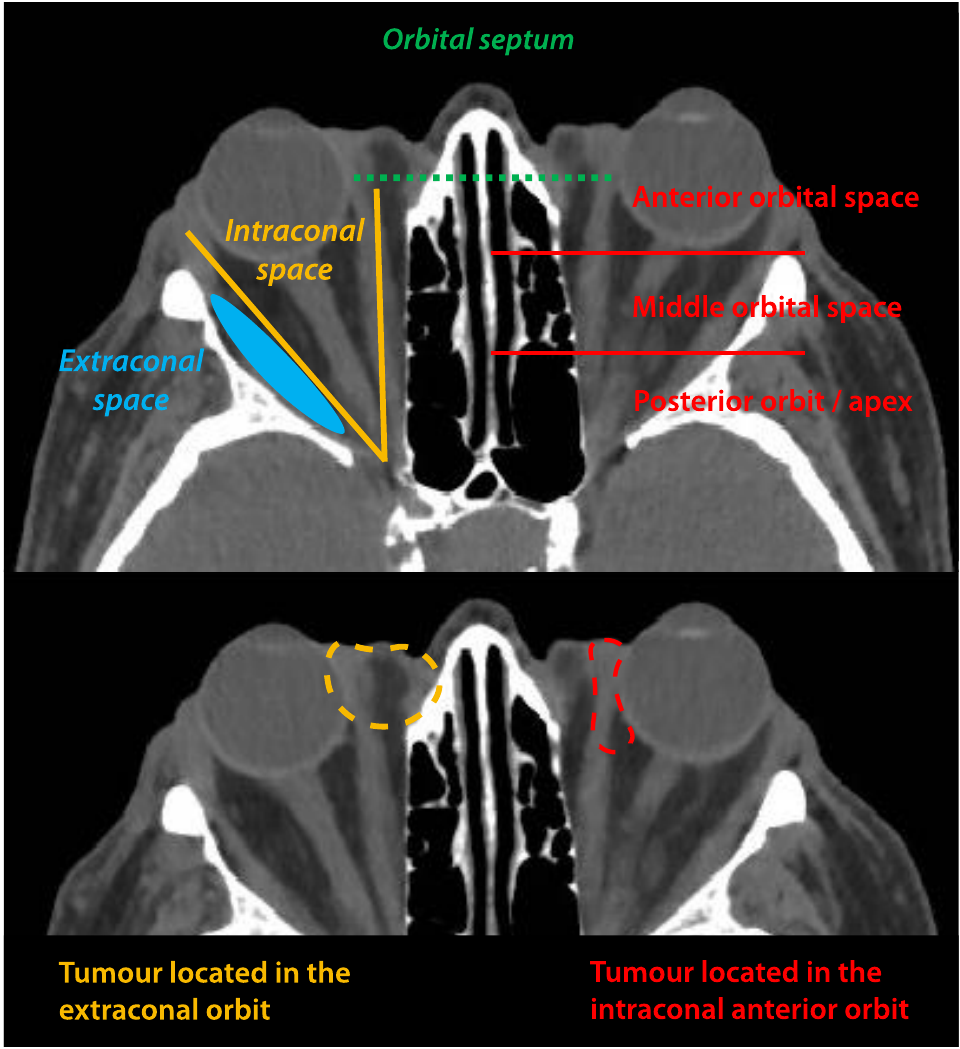
Figure 7. Schematic representation of the different surgical orbital spaces. Conjunctival melanomas located in the intraconal space are not accessible to conservative surgery.